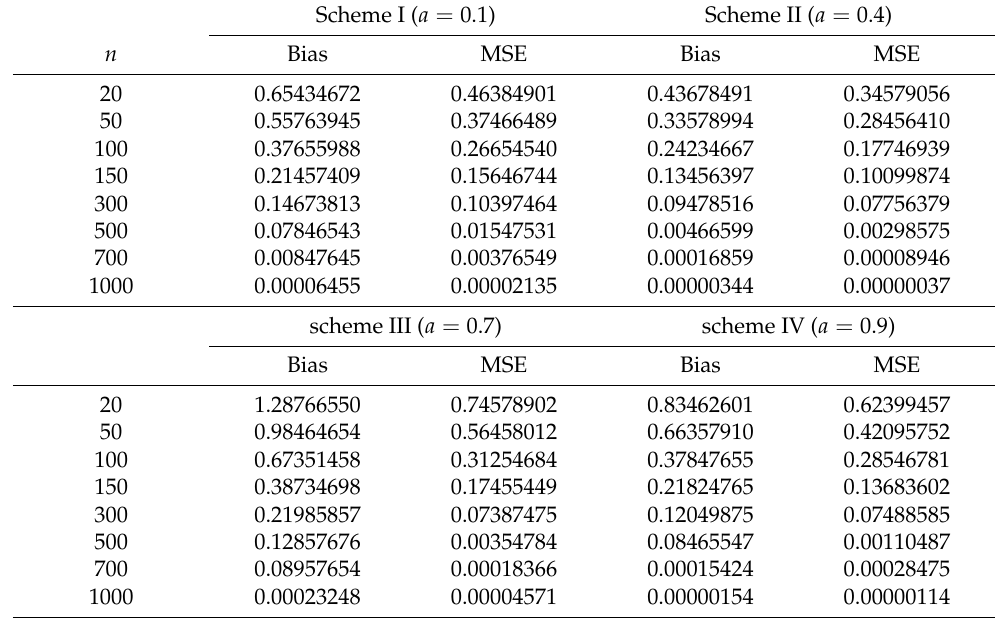
Table 1. Simulation results for DWPLT parameters using the MLE method.